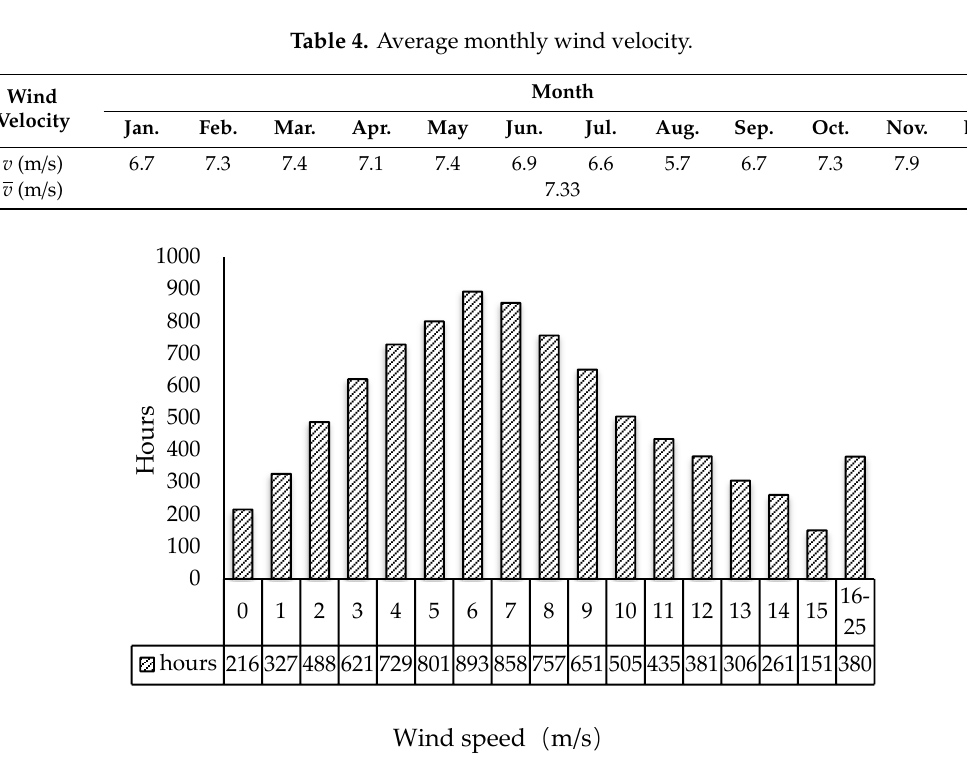
Figure 5. Annual wind speed frequency distribution at the location of the case.